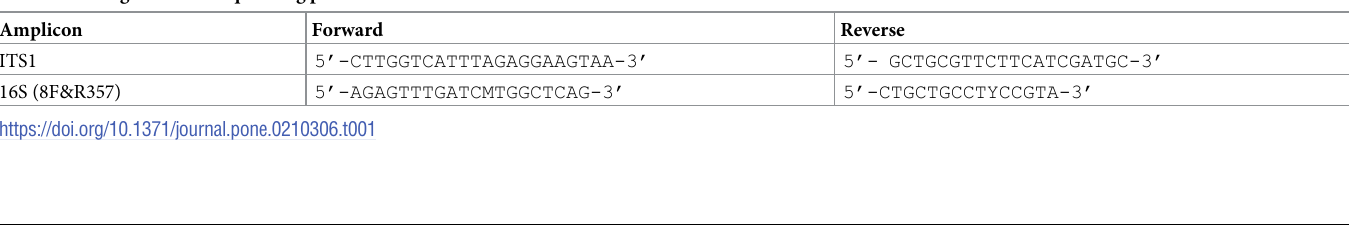
Table 1. Next-generation sequencing